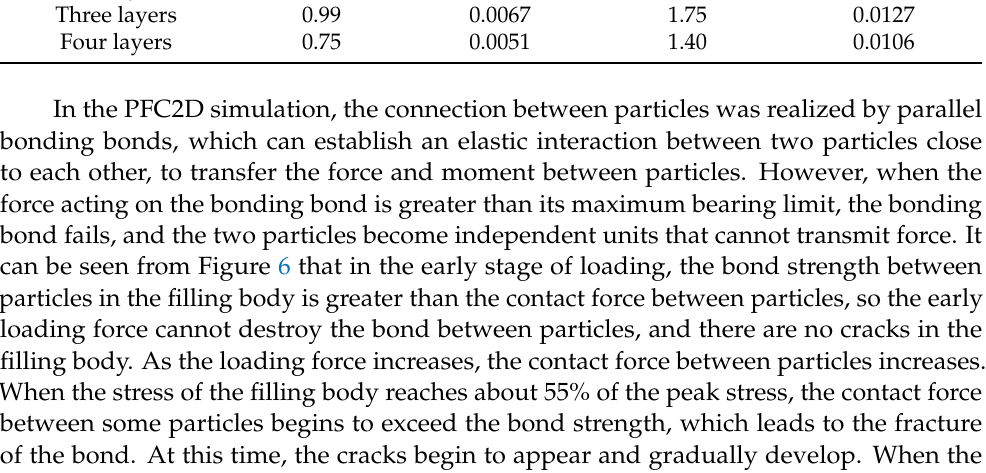
Figure 8. Composite diagram of stress – strain curve and crack increment curve of numerical model of horizontal layered filling body; ( a ) one layer, ( b ) two layers, ( c ) three layers, ( d ) four layers.